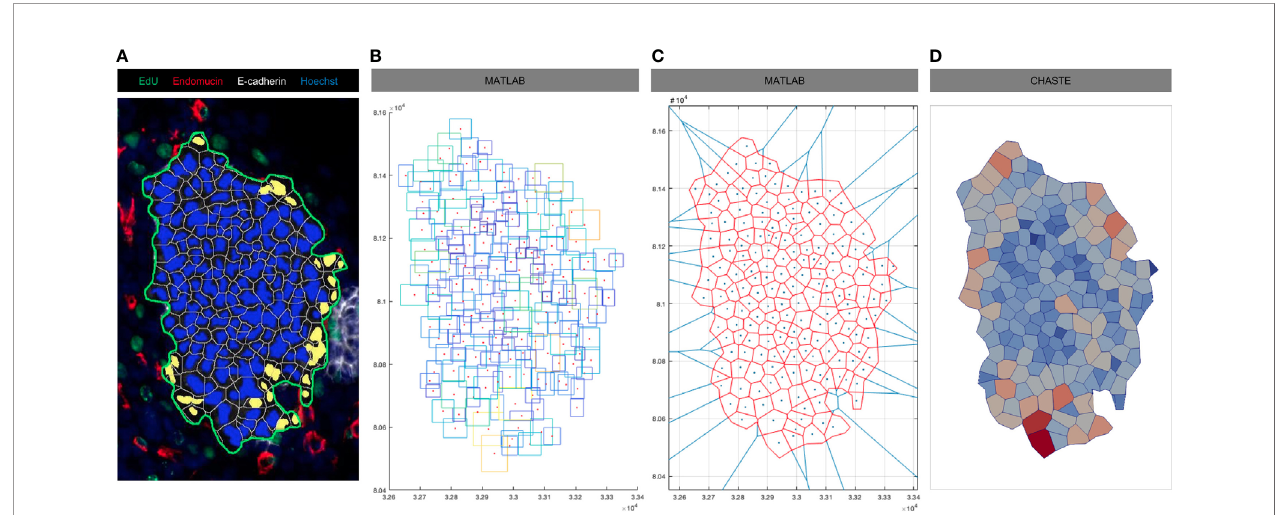
FIGURE 2 | Process of initial condition generation from microscopic imagery. (A) E13.5 thyroid section labelled for E-cadherin (white), Endomucin (red), EdU (green) and nuclei (blue). Epithelial cell nuclei were coloured in blue and endothelial cell nuclei in yellow using HALO. The area of analysis is delineated by a green line (B) Rectangles enclosing epithelial and endothelial cells identi fi ed in (A) were recreated in MATLAB with a red dot localized in the centre of each of these rectangles. Contours of rectangle are coloured according to their area (increasing from blue to yellow). (C) Voronoi diagram was generated in MATLAB using cell centres from (B) as seeds. Original tesselation in blue, fi nal tesselation using the manual annotation of the area of analysis (A, in green) as boundary in red. (D) Visualisation of the fi nal cell population in Chaste that will be further used as initial condition in our simulations. Cell are coloured according to their area (increasing from blue to